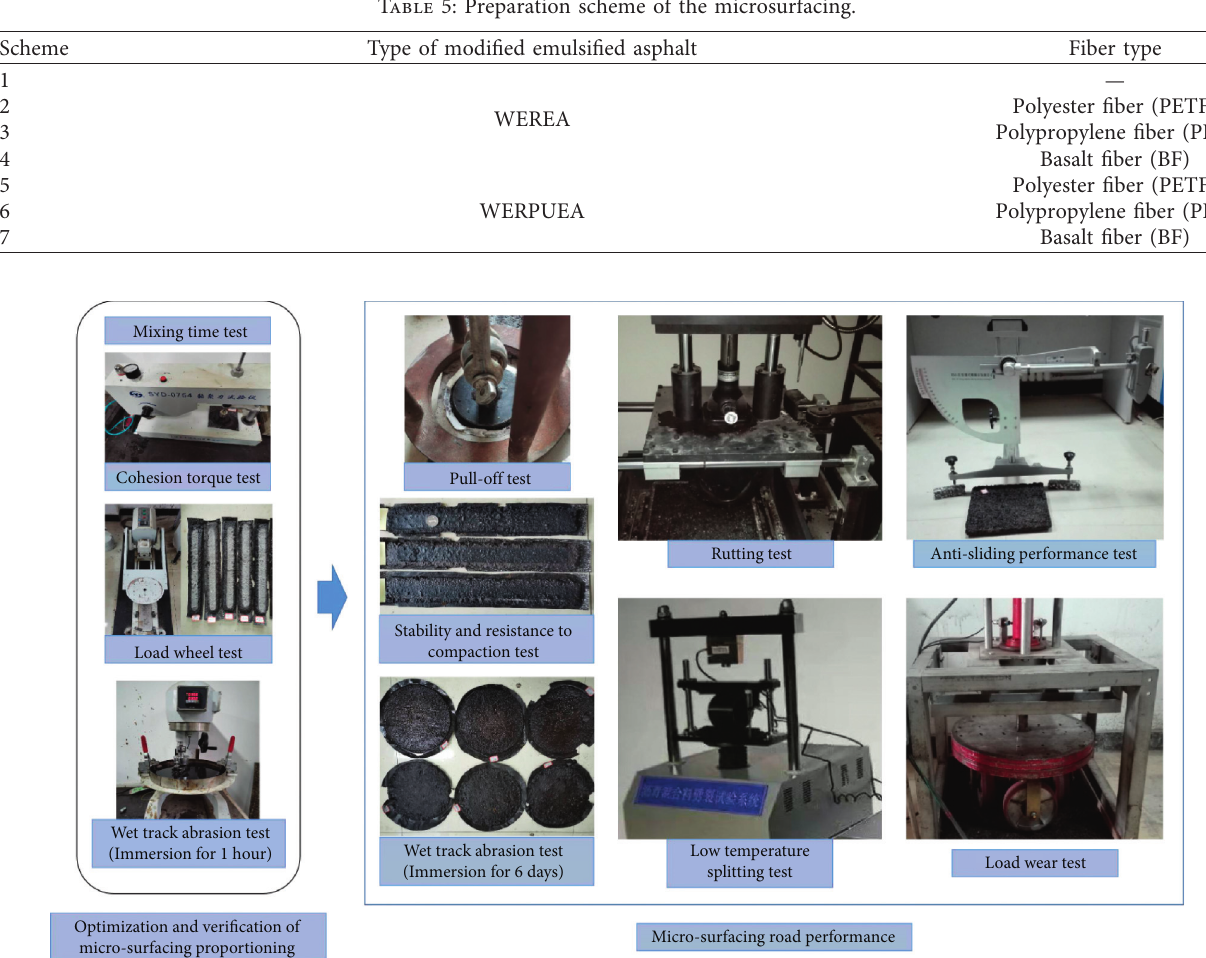
Table 5: Preparation scheme of the